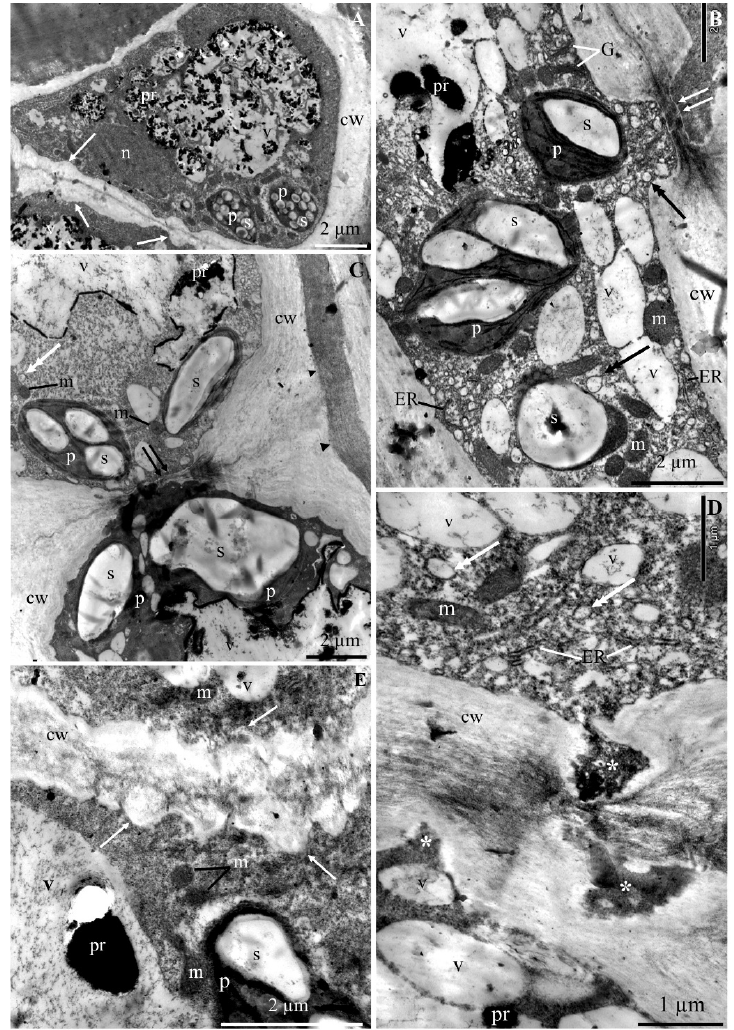
Figure 1. Fragments of the cross sections of epidermis and adjacent hypodermis cells from the apical part of ‘Szampion’ apples from the control treatment. A : epidermis cell, cell wall (cw) with invaginations (arrow), amyloplasts with starch grains (p), Golgi apparatus (G), cell nucleus (n), centrally located large vacuole (v) with dark material in cell sap (pr). B : epidermis cell with a visible cell wall (cw), middle lamella (two arrows), amyloplasts (p) with starch grains (s), mitochondria (m), transport vesicles (double-headed arrow), endoplasmic reticulum (ER), one large and several small vacuoles (v), precipitates (pr). C : hypodermis cells, visible cell wall with a dark-stained middle lamella (arrowhead), the middle lamella delineates the protoplasts of adjacent cells (two arrows), plastids (p) with starch grains (s), transport vesicles (double-headed arrow), discontinuous black-stained tonoplast (t). D : epidermis cell, visible cell wall discontinuity (cw), mitochondria (m), numerous transport vesicles (double-headed arrow), endoplasmic reticulum (ER), one large vacuole (v) or several small vacuoles with black-stained deposits (pr), cell wall evaginations (asterisk). E : epidermis and hypodermis cell wall (cw) with numerous invaginations (asterisk), mitochondria (m), plastids with starch grains (p), vacuole (v) with a fibrous substance and precipitate (pr).